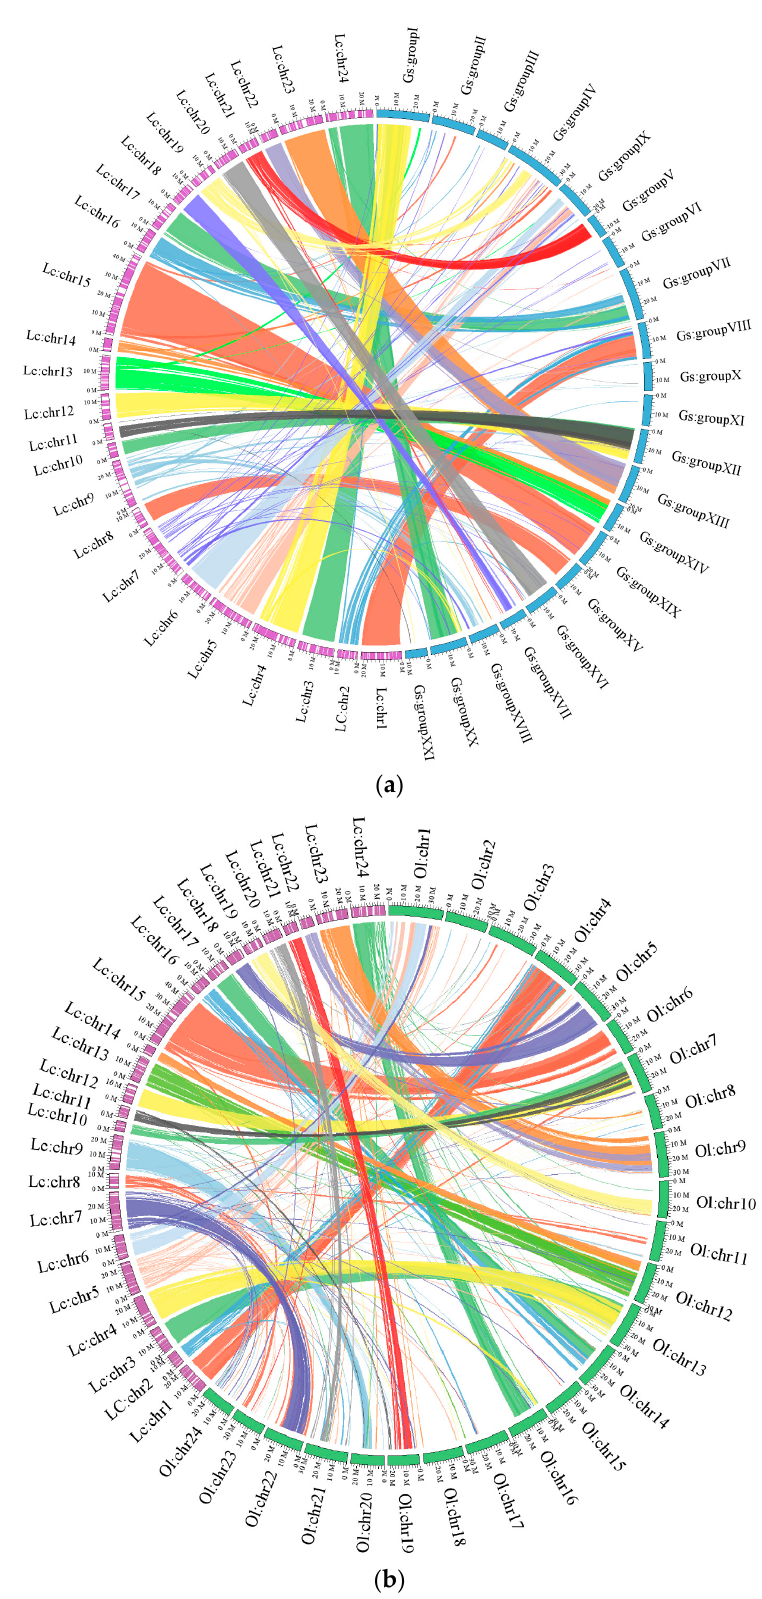
Figure 3. Circos atlas represents the collinear relationships between large yellow croaker and ( a ) stickleback and ( b ) medaka. The circle represents the length of each chromosome. Each colored line presents an orthologous match between two species. Ol: Oryzias latipes ; Gs: Gasterosteus aculeatus ; Lc; Larimichthys crocea .